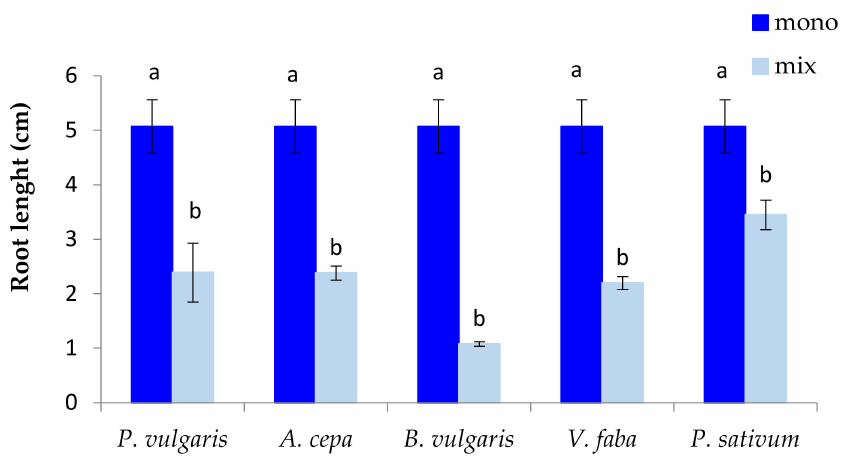
Figure 7. Root length of P. oleracea grown with crop seeds (mono = weed alone; mix = weed grown together with crop). Bars represent the means of 4 replicates ± SE. Bars topped by the same letter indicate no significant difference between treatments at the 5% level using Duncan’s multiple-range